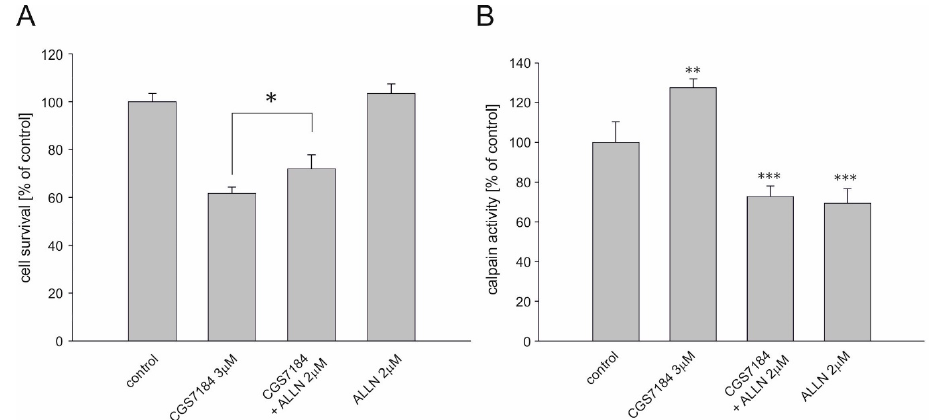
Figure 7. Toxicity induced by CGS7184 involves the activation of calpains. ( A ) HT22 cells were treated with 3 µM CGS7184 alone or in the presence of 2 µM calpain inhibitor I (ALLN). Cell survival was measured using the MTT assay 18 h after insult. ( B ) HT22 cells were treated with 3 µM CGS7184 alone and in the presence of 2 µM calpain inhibitor I (ALLN). Calpain activity was measured using the Calpain-Glo assay 30 min after treatment. All data are expressed as means ± SEM from three ( A ) and four ( B ) independent experiments with three replicates per data point. * p < 0.05, ** p < 0.01, and *** p < 0.001 by one-way ANOVA followed by Tukey’s test.